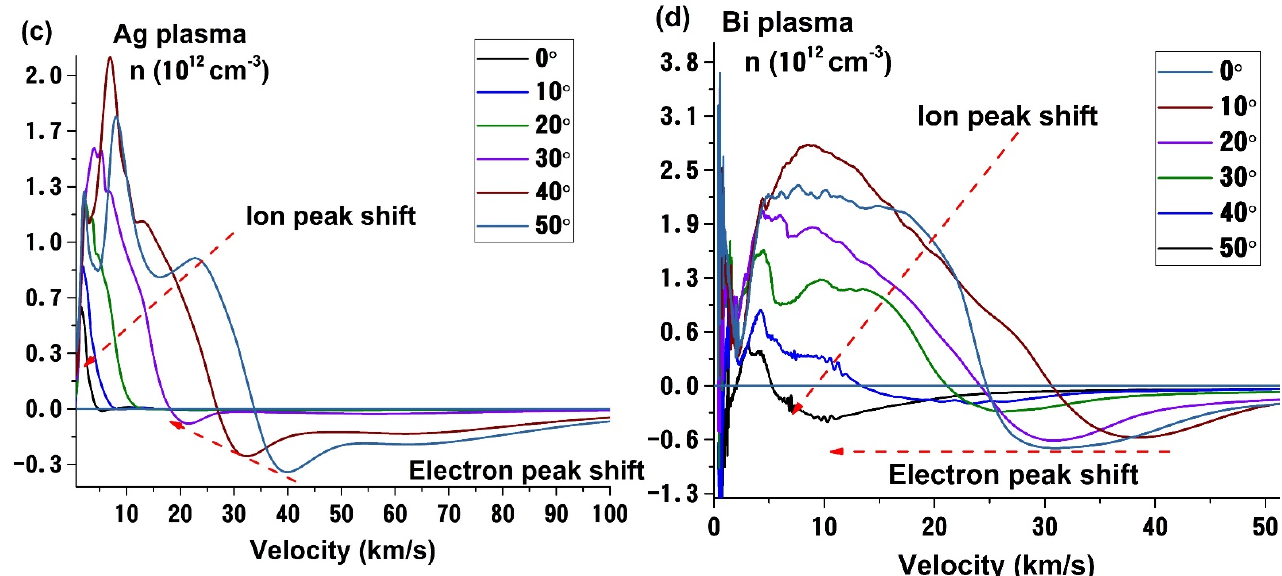
Figure 5. Angular dependence of charged particle velocity distribution for the investigated metallic plasmas (Co ( a ); Cu ( b ); Ag ( c ); Bi ( d )).